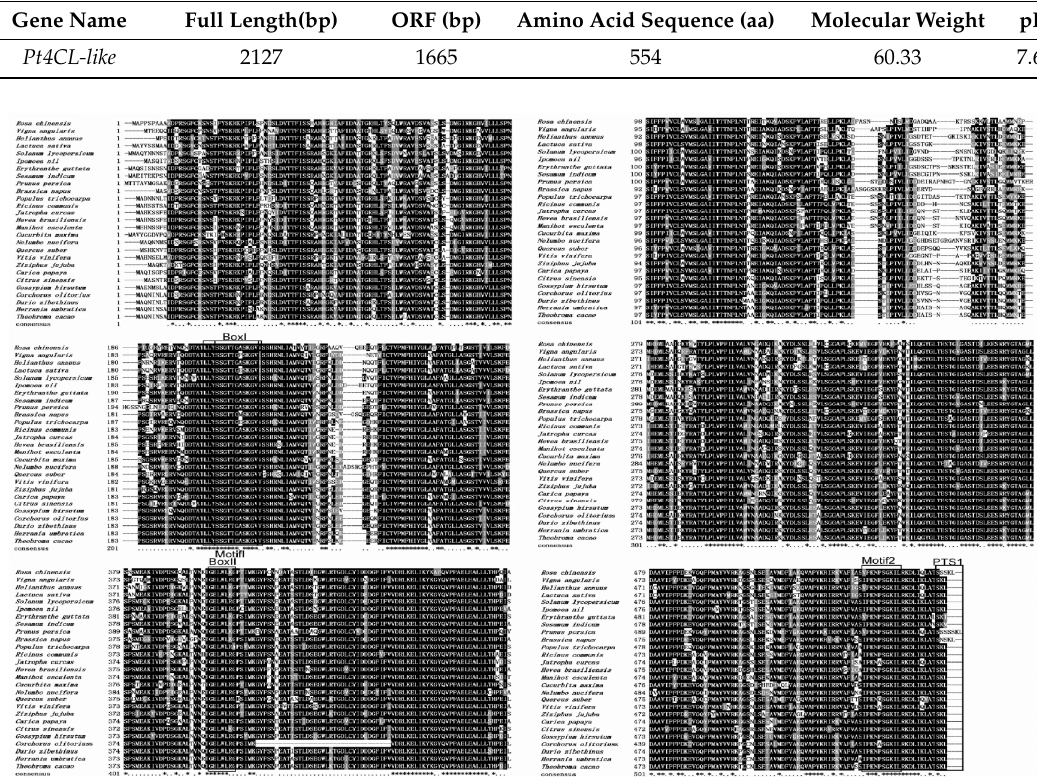
Table 2. Length, open reading frame (ORF), amino acid sequence length, molecular weight, and predicted isoelectric points (pI) of Pt4CL-like deduced protein are shown.